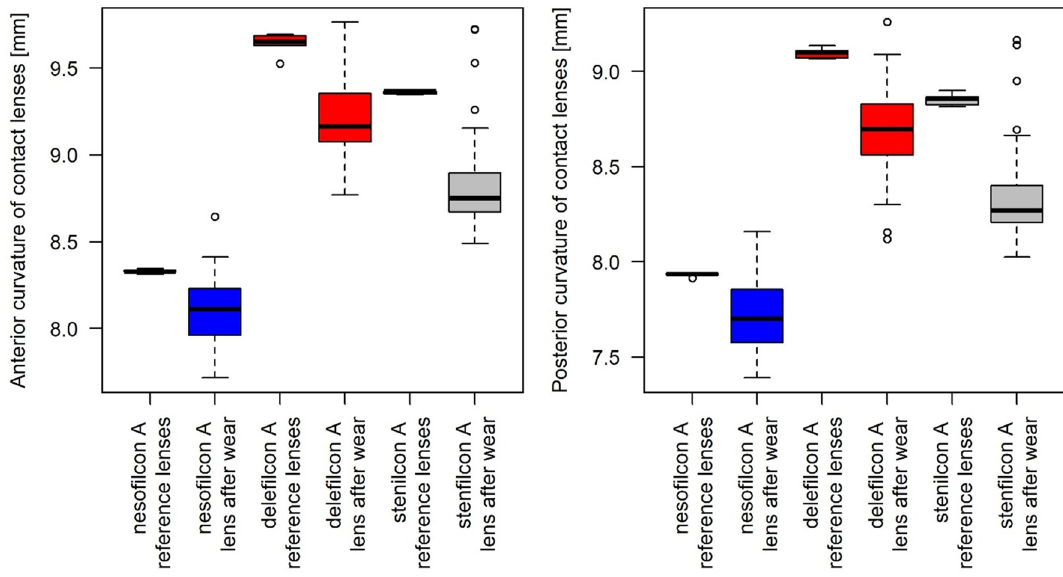
Figure 3. Changes in the anterior and posterior radii of curvature for three types of daily disposable SCLs.